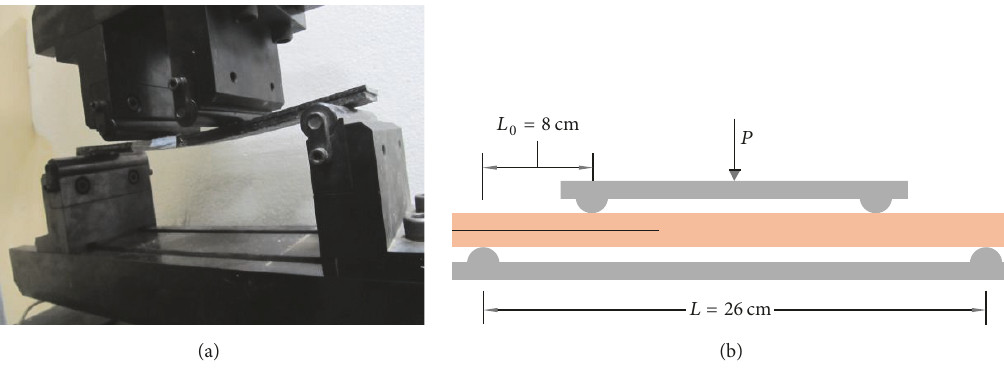
Figure 5: Testing configuration: (a) MTS apparatus; (b) schematic diagram for 4-ENF test.